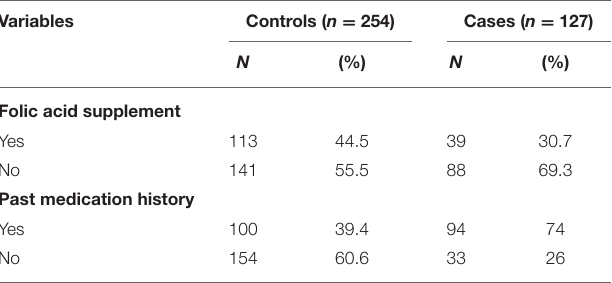
TABLE 3 | Frequency distribution of medication-related factors among case and control groups in Debre Berhan Specialized Hospital, 2021. Variables